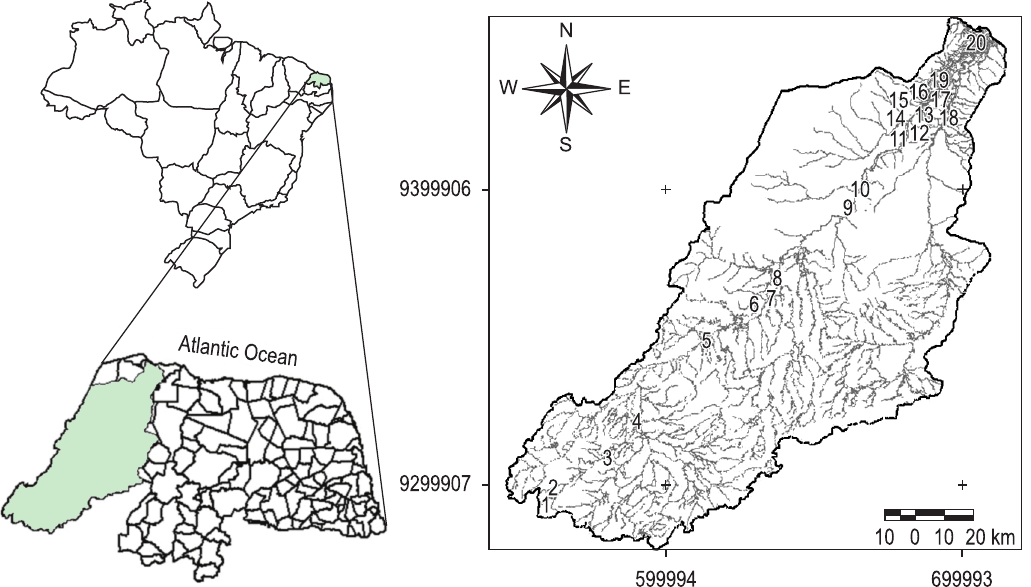
Figure 1. Location and hydrography of the Apodi/Mossoró river basin, RN, Northeast Brazil, with the 20 sam- pling station. Geographical coordinates: Station 1: 06° 22’ 10’’ S and 038° 27’ 39’’ W; Station 2: 06° 22’ 08’’ S